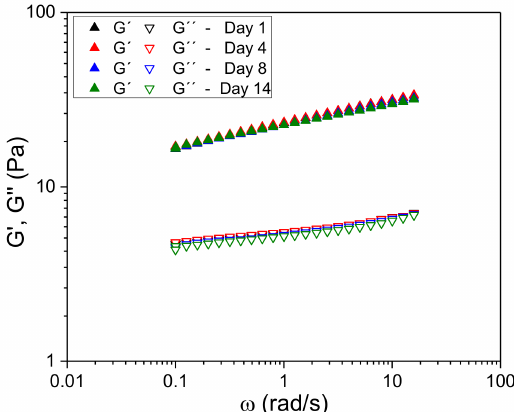
Figure 6. Mechanical spectra as a function of aging time for fennel oil nanoemulsion formulated with advanced performance xanthan gum (0.70 g/100 g) at 20 ◦ C. Data shown are the average values of three replicates. The standard deviation of for all the experiments was lower than